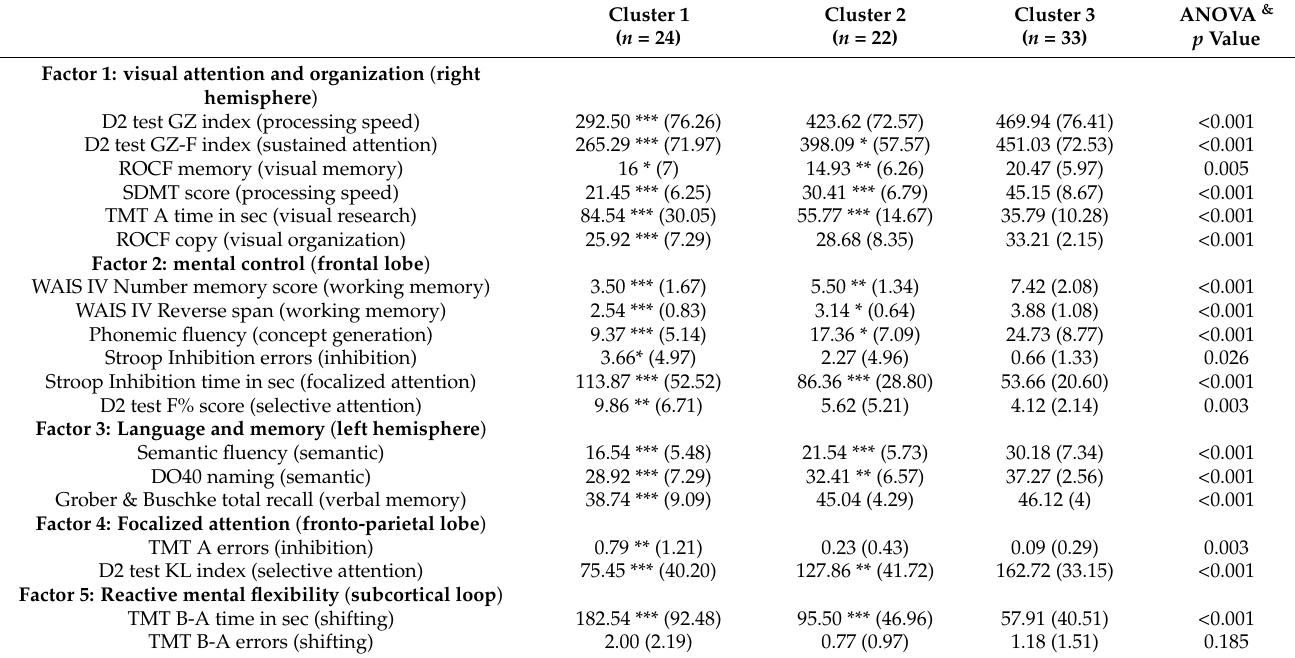
Table 3. Clusters’ performance on individual neurocognitive tasks. Individual tasks are organized according to the five factors identified from the principal component analysis. For each cluster, the mean scores (with standard deviation) on individual tests are presented. Cluster 3 was defined as the reference group for inter-cluster comparisons.